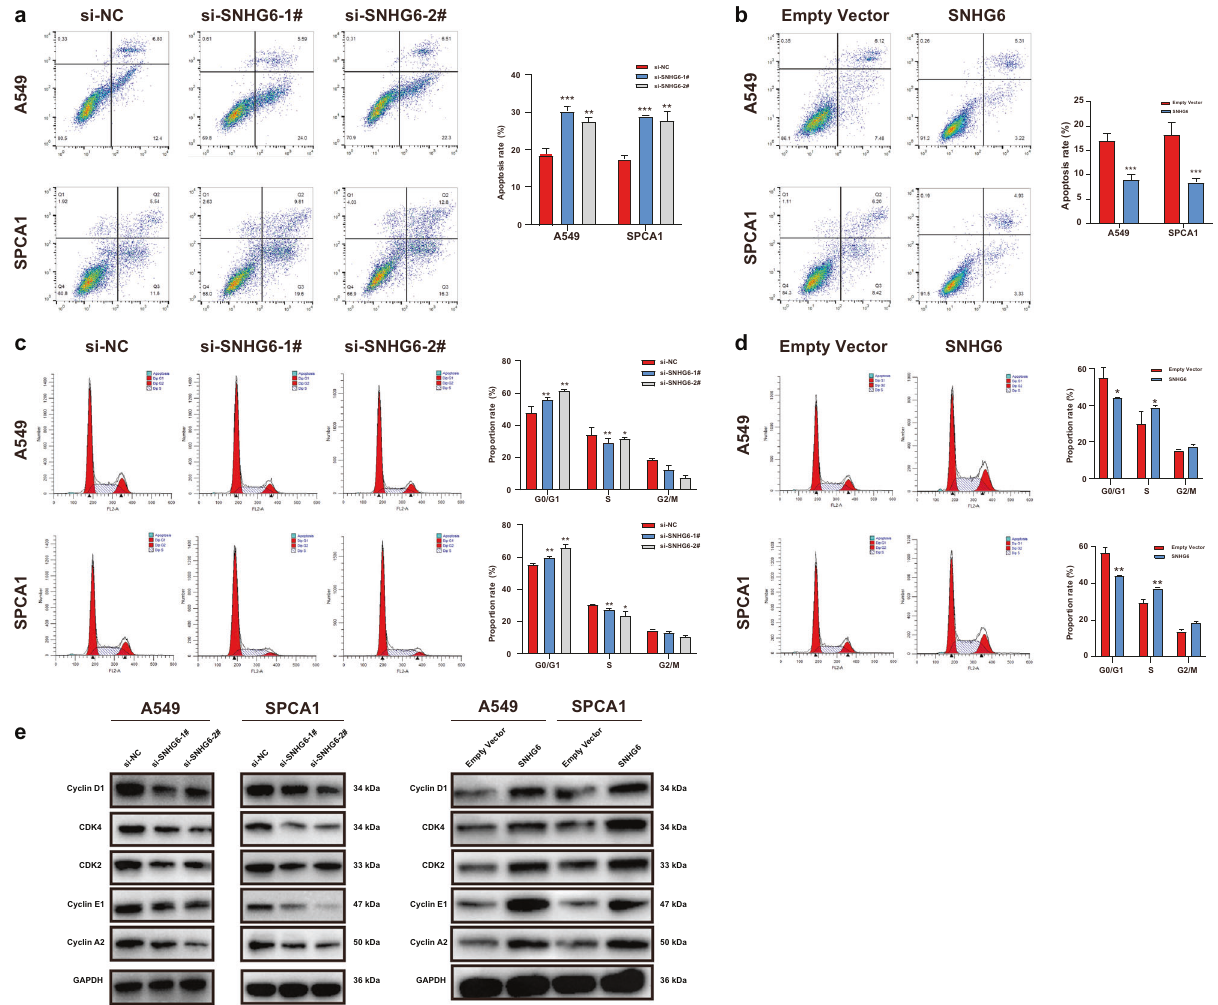
Fig. 3 SNHG6 knockdown suppressed G1/S transition and promoted cell apoptosis. a SNHG6 knockdown facilitated cell apoptosis in NSCLC cell lines; b SNHG6 overexpression inhibited cell apoptosis of A549 and SPCA1 cells; c SNHG6 knockdown decreased NSCLC cells in the S phase and increased the cells in the G0/G1 phase; d The overexpression of SNHG6 promoted G1/S transition; e SNHG6 suppression downregulated the expression of cyclin D1, CDK2, CDK4, cyclin A2, and cyclin E1 and SNHG6 overexpression represented the opposite effects. The results were from three independent experiments. Data were analyzed by unpaired student ’ s t -test. *** P < 0.001, ** P < 0.01, * P < 0.05. Variables were presented as the mean ±